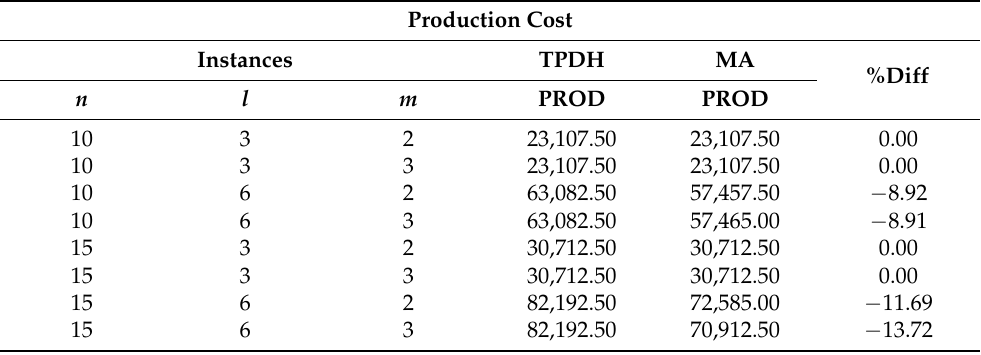
Table 18. Comparison of total production